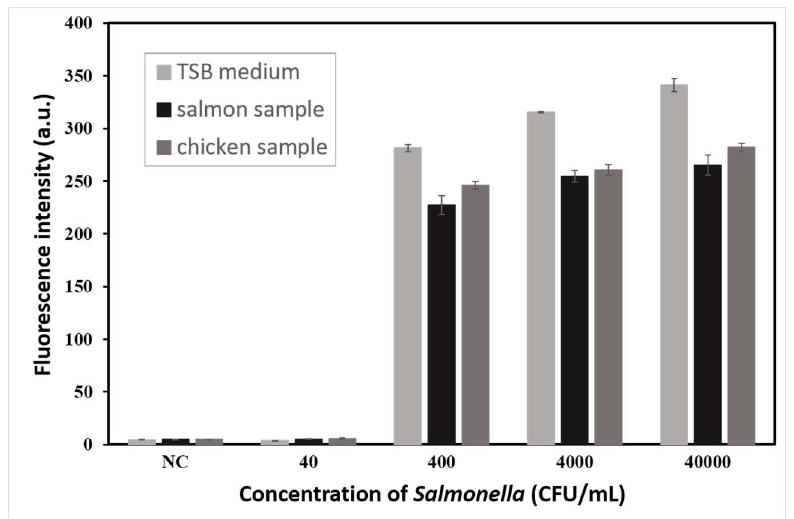
Figure 6. Matrixes test results of LAMP–CRISPR detection system for Salmonella detection in TSB medium, salmon sample, and chicken sample spiked with Salmonella (4 × 10 1 , 4 × 10 2 , 4 × 10 3 , and 4 × 10 4 CFU/mL).